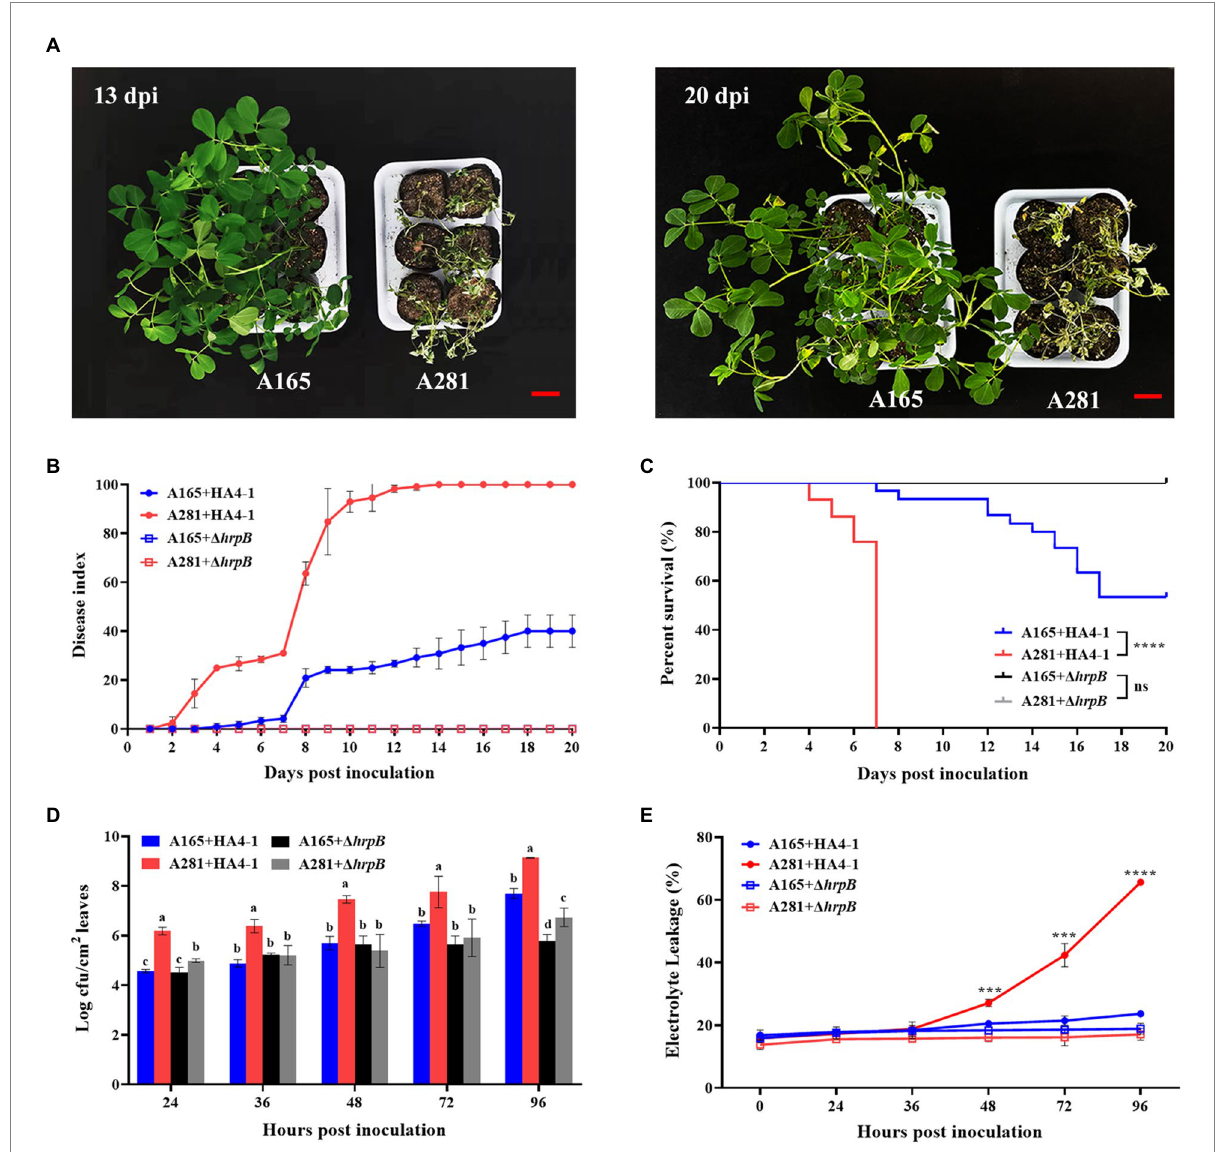
FIGURE 1 The phenotype of A165 and A281 inoculated with R. solanacearum HA4-1 by the cutting leaf method. (A) Disease symptoms of A165 and A281 inoculated with HA4-1 at 13 dpi and 20 dpi. Bar = 5 cm. (B) Disease index of A165 and A281 inoculated with HA4-1 and Δ hrpB mutant (mean ± SE). (C) Survival analysis of A165 and A281 inoculated with HA4-1 and Δ hrpB mutant (**** p < 0.0001, “ns” means no significant difference). (D) R. solanacearum populations in leaf tissues of A165 and A281 inoculated with HA4-1 and Δ hrpB mutant. Different lowercases indicate significant differences according to ANOVA (mean ± SE, p < 0.05). (E) Electrolyte leakage in leaf tissues of A165 and A281 inoculated with HA4-1 and Δ hrpB mutant. The asterisks indicate significant differences between A165 and A281 according to Student’s t -test (mean ± SE, *** p < 0.001, **** p <